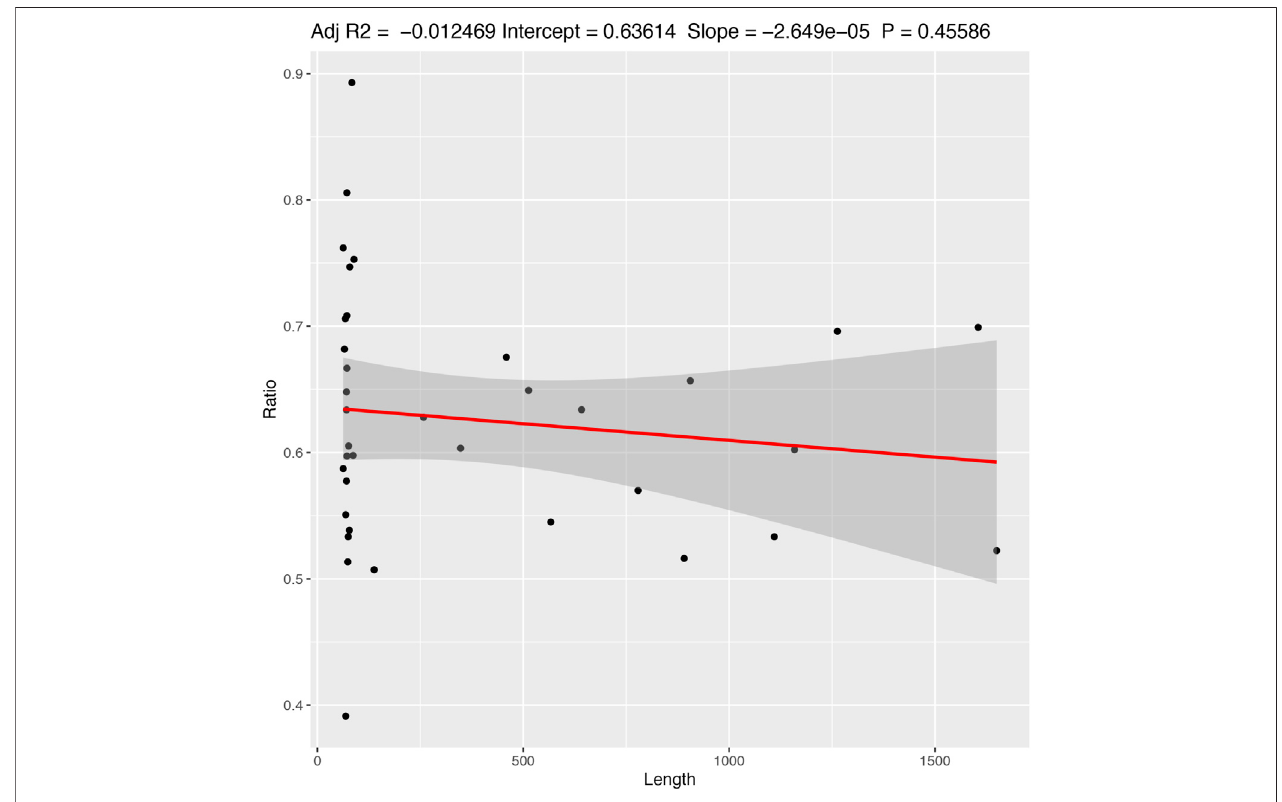
FIGURE 5 | Correlation between the frequency of informative characters and sequence length. Adjusted R2 (cid:1) − 0.012469; Intercept (cid:1) 0.63614; Slope (cid:1) − 2.649e − 05; p -value (cid:1) 0.45586.